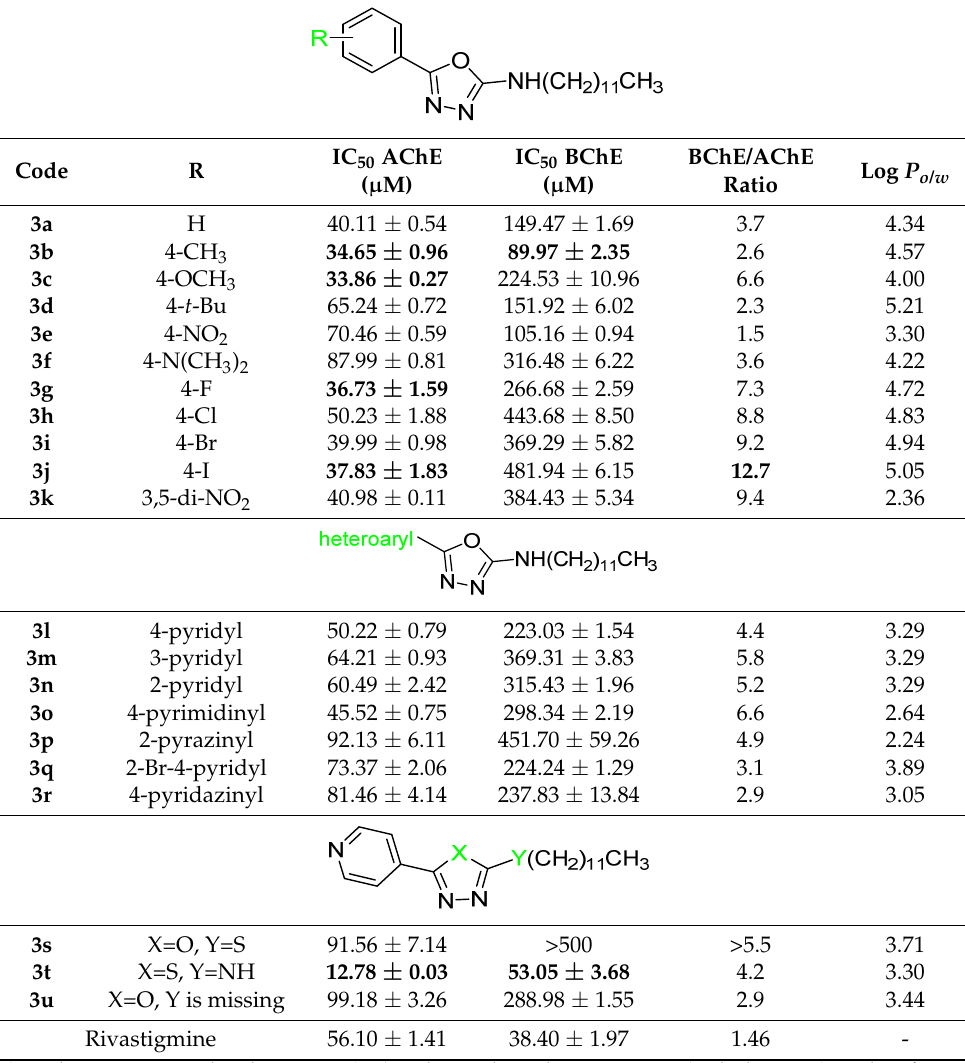
Table 1. Inhibition of AChE and BChE and selectivity indexes of the heterocycles 3 .